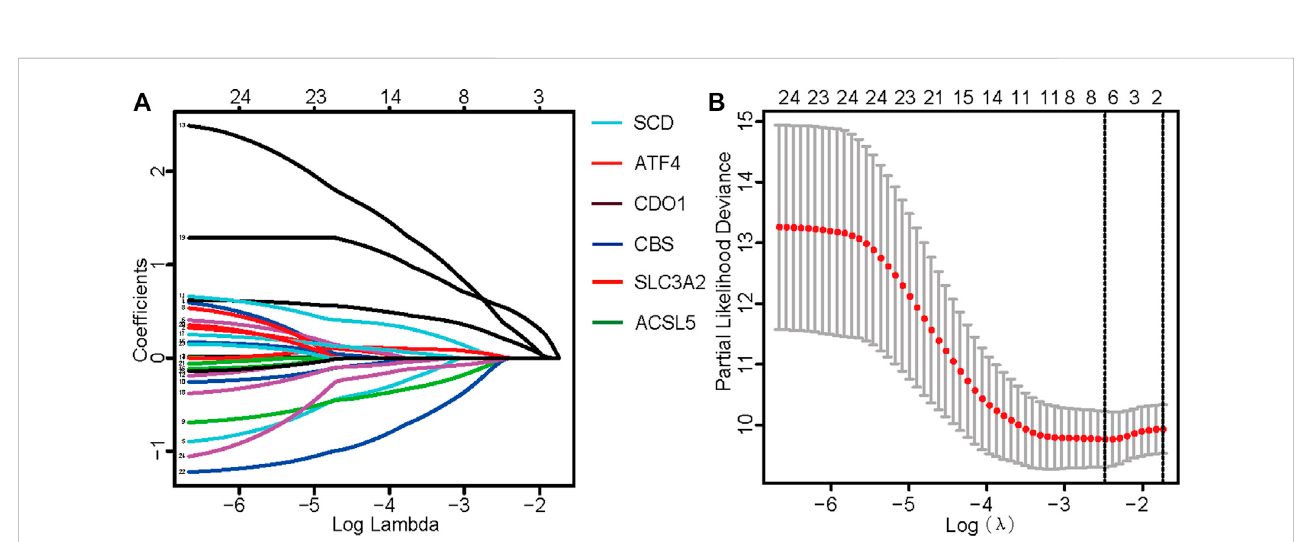
FIGURE 2 Identi fi cation of ferroptosis-related genes with prognostic value for osteosarcoma. (A) Fitting parameters of the LASSO regression model. (B) LASSO coef fi cient pro fi le of genes associated with